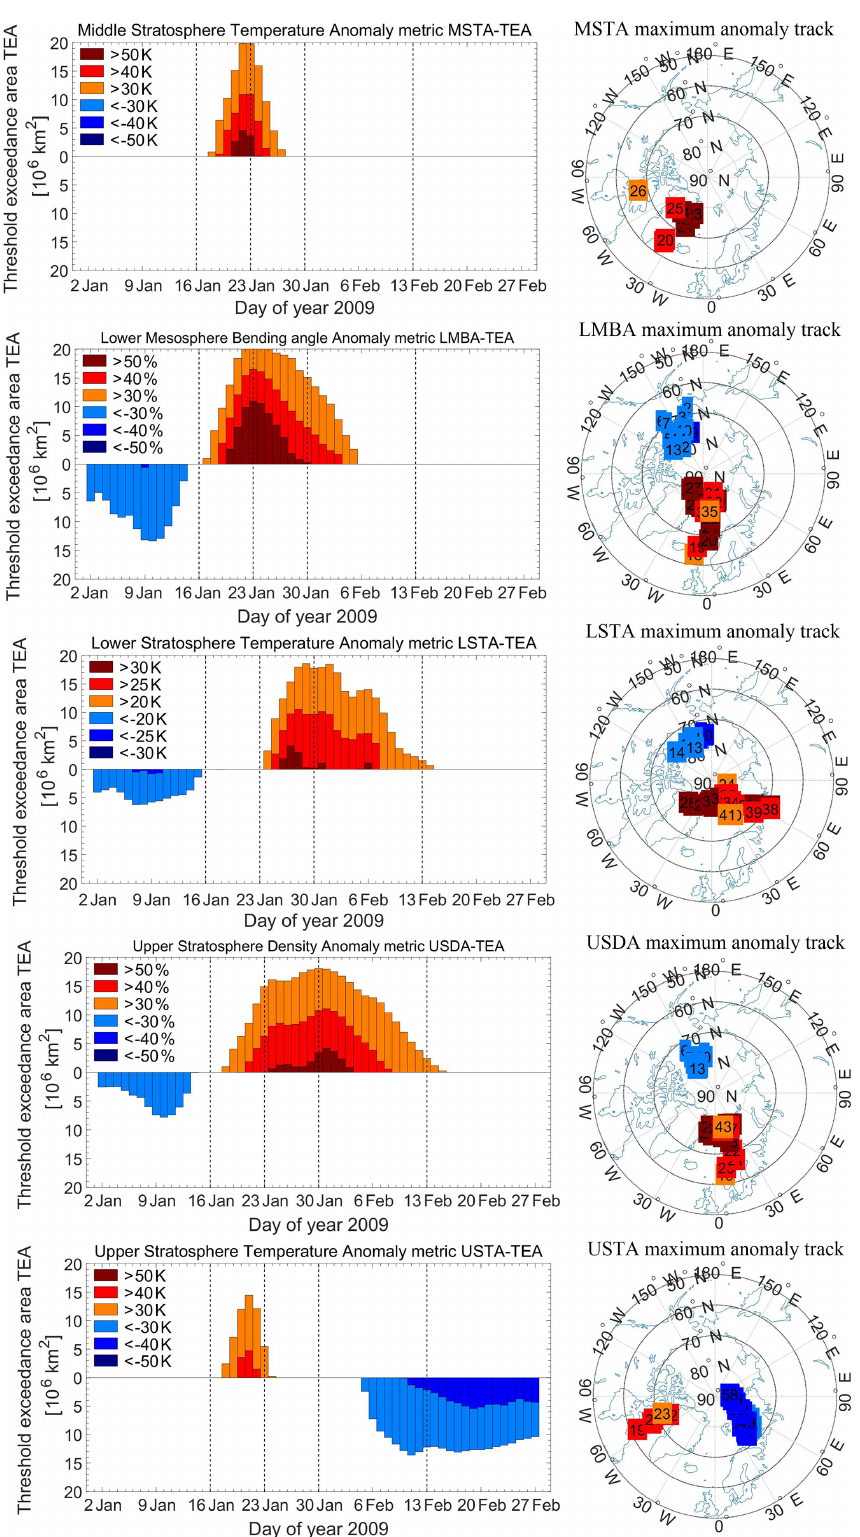
Figure 6. Time evolution of the daily MSTA, LMBA, LSTA, USDA, and USTA (from top to bottom) threshold exceedance areas (TEAs) during the SSW event, using thresholds according to Table 1, (4)–(8) (left column). For complementary space–time dynamics information, geographic tracks and magnitude classes (color scheme of left panels, numbering by day of year) of maximum positive/negative anomaly values are shown for days with TEAs with smallest thresholds > 3 × 10 6 km 2 (right